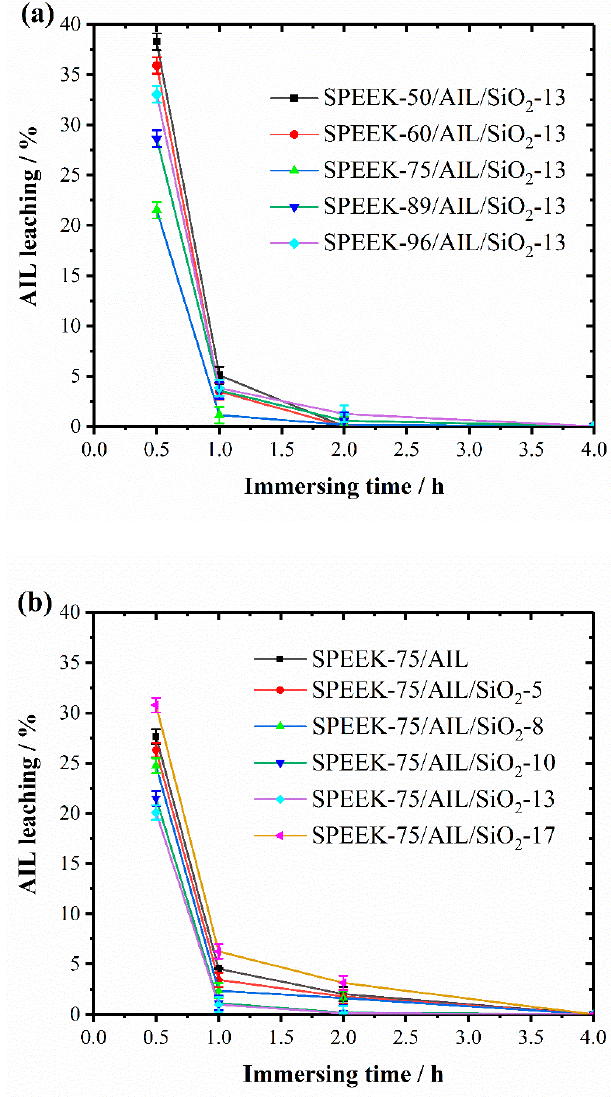
Figure 8. The AIL leaching of the SPEEK/AIL/SiO 2 composite membranes with different DSs ( a ) and SiO 2 content ( b ) as a function of time.